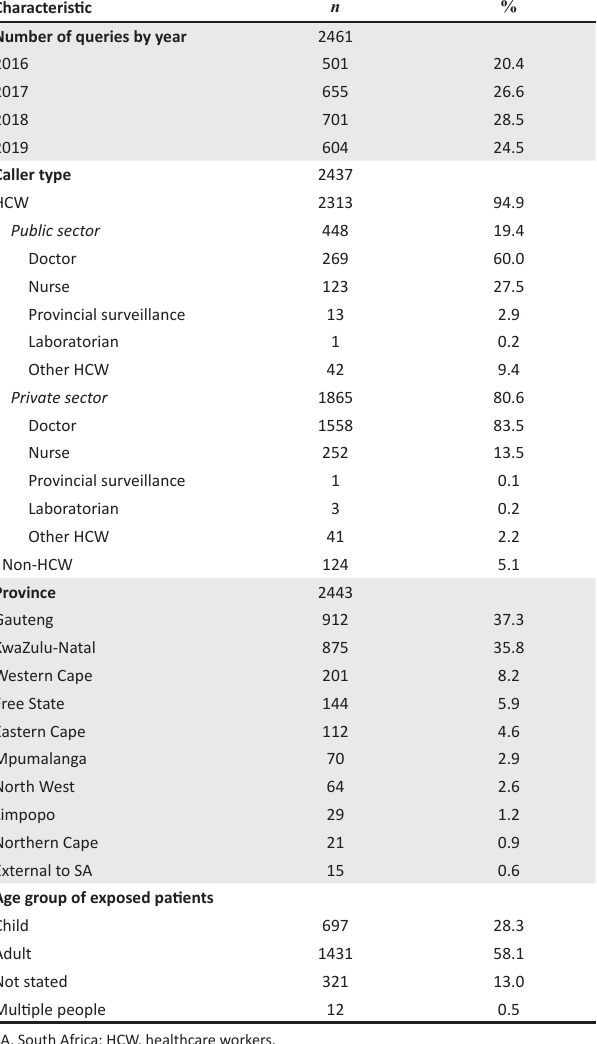
TABLE 2: Characteristics of rabies post-exposure prophylaxis queries to the National Institute for Communicable Diseases clinician hotline from 01 January 2016 to 31 December